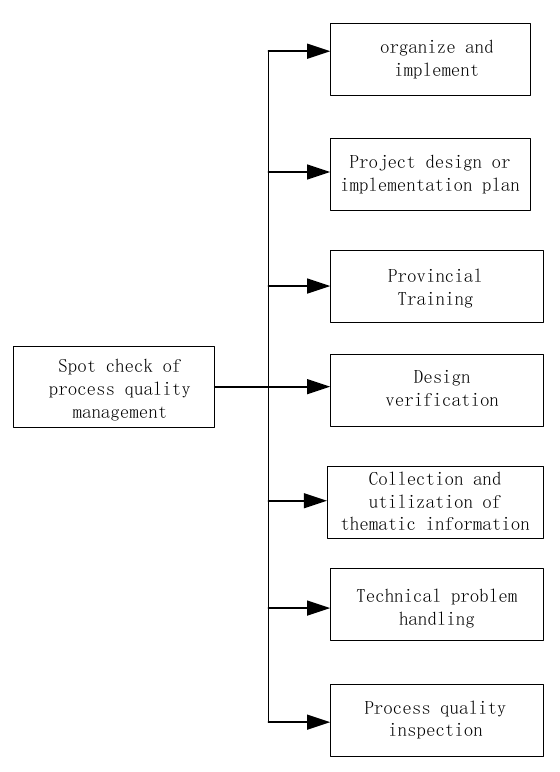
Figure 6. Inspection of quality control during